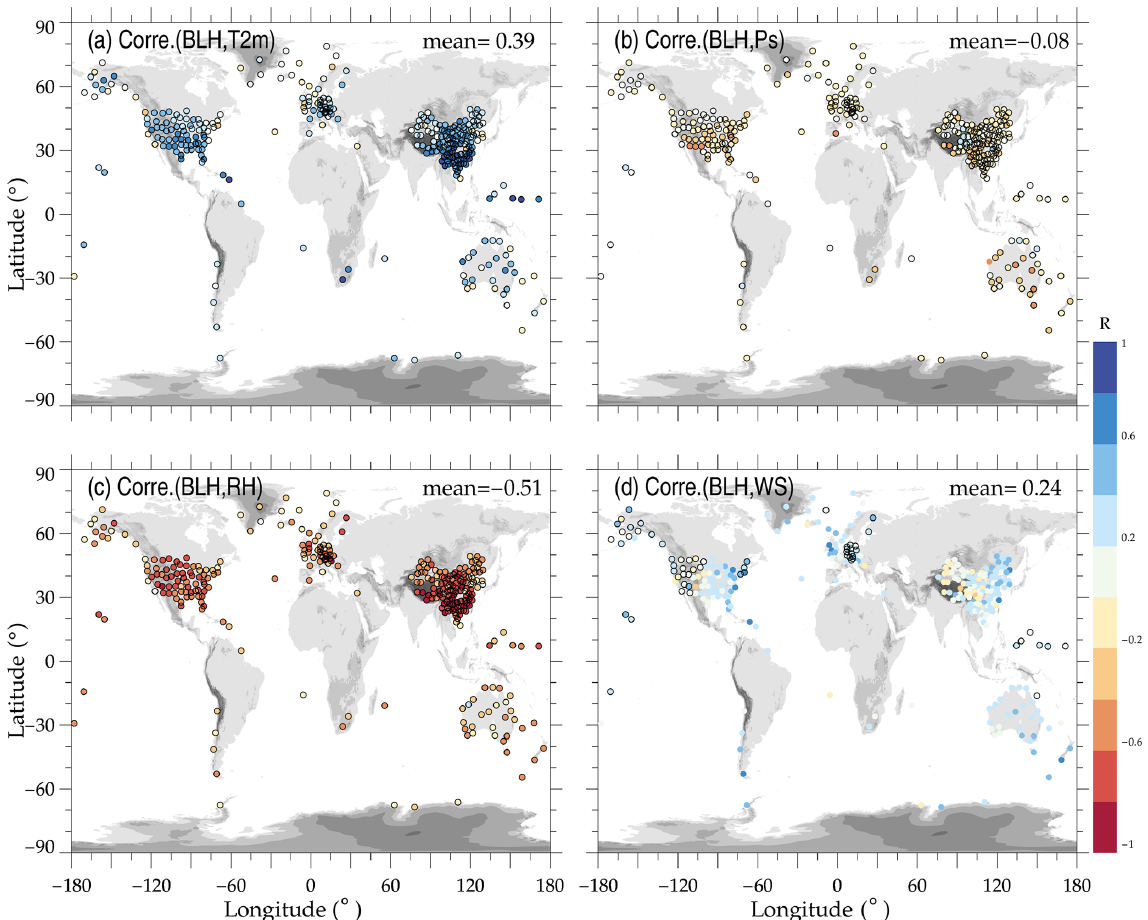
Figure 5. Correlations between the radiosonde-derived BLHs and near-surface air temperature at 2ma.g.l. ( T 2m ; a ), near-surface pressure (Ps; b ), near-surface RH (c) , and near-surface wind speed (WS; d ). Dots outlined in black denote that the correlation coefficient values are statistically significant ( p< 0 . 05), and the mean correlations are written in the upper right corner of each